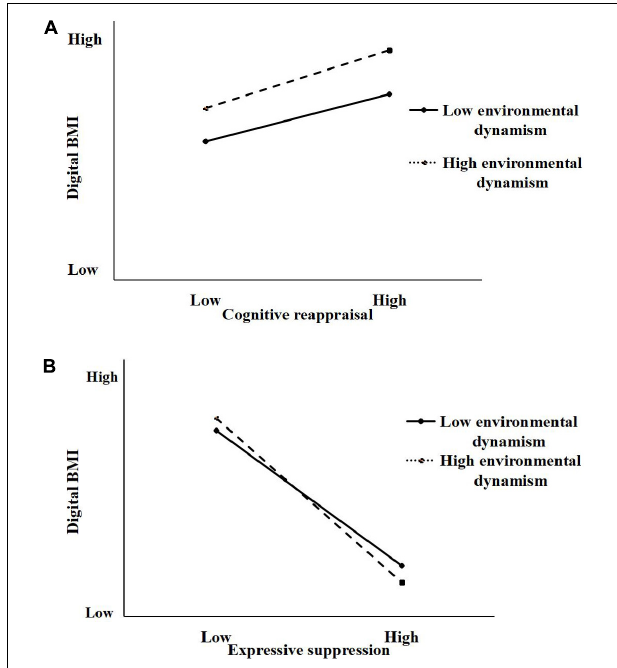
FIGURE 1 | (A) Cognitive reappraisal × environmental dynamism interaction (H2a). (B) Expressive suppression × environmental dynamism interaction